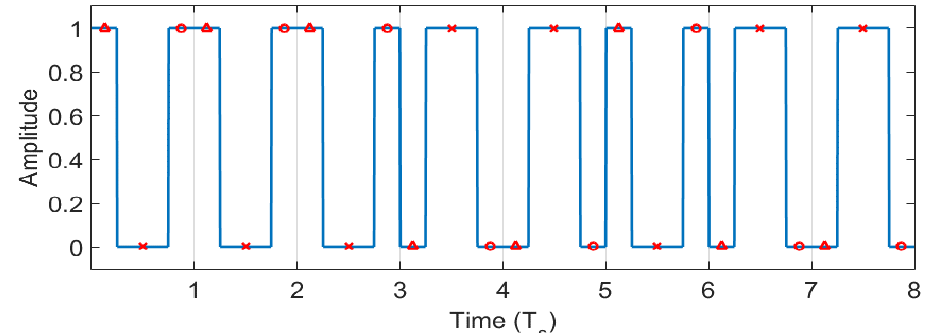
Figure 2. The waveform for the binary sequence 00011011 and the sampling points of interest.